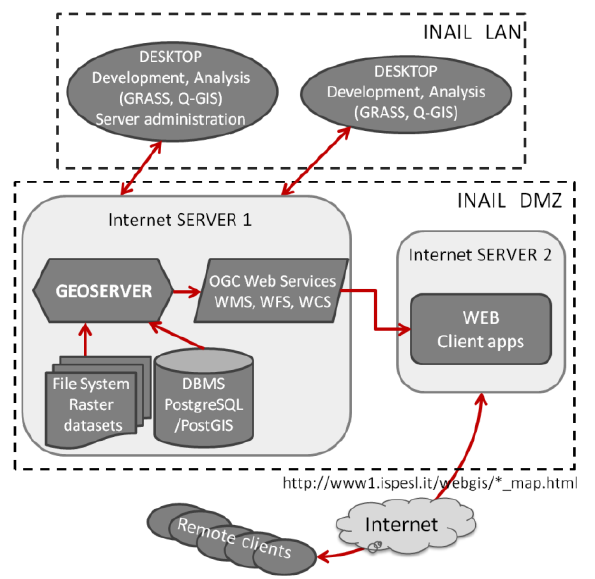
Figure 1. EXPAH-GIS Client/Server architecture